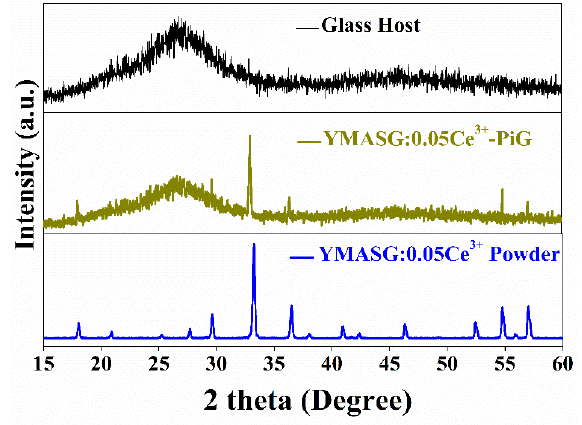
Figure 4. The XRD patterns of YMASG:0.05Ce 3+ and 8 wt % YMASG:0.05Ce 3+ PiG composite.